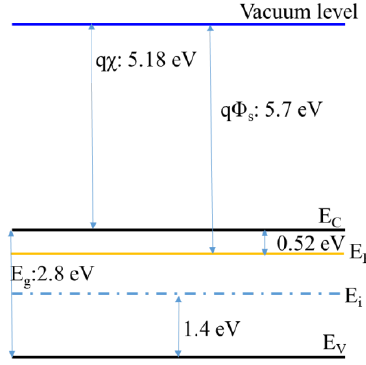
Figure 5. Schematic diagram of band diagram of WO 3 film as an n-type semiconductor.